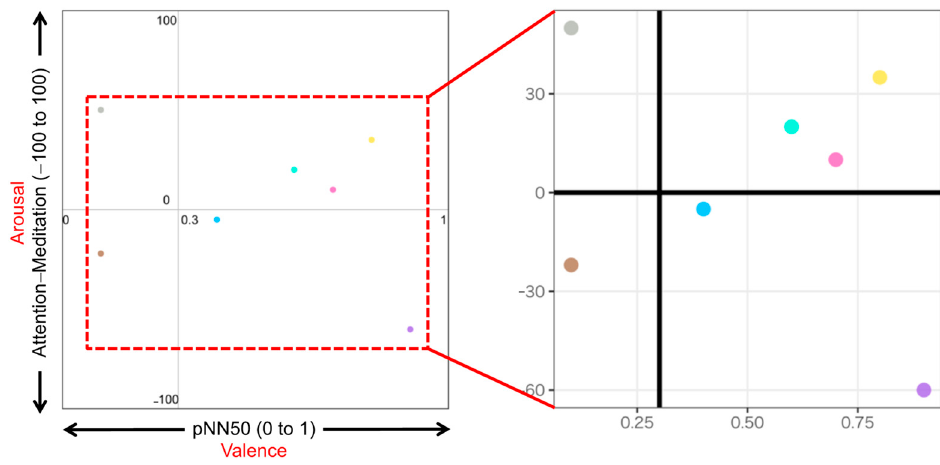
Figure 4. Example of an emotion map using Attention − Meditation as Arousal index and pNN50 as Valence index. The dots with different colors indicate the different olfactory stimuli.